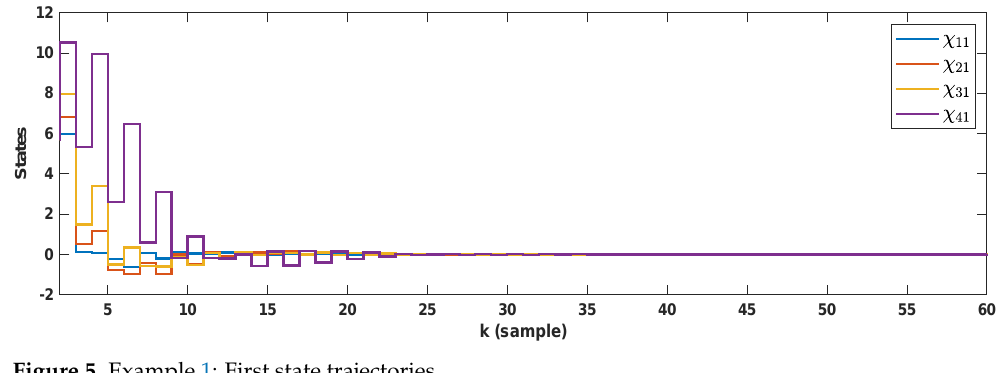
Figure 5. Example 1: First state trajectories.